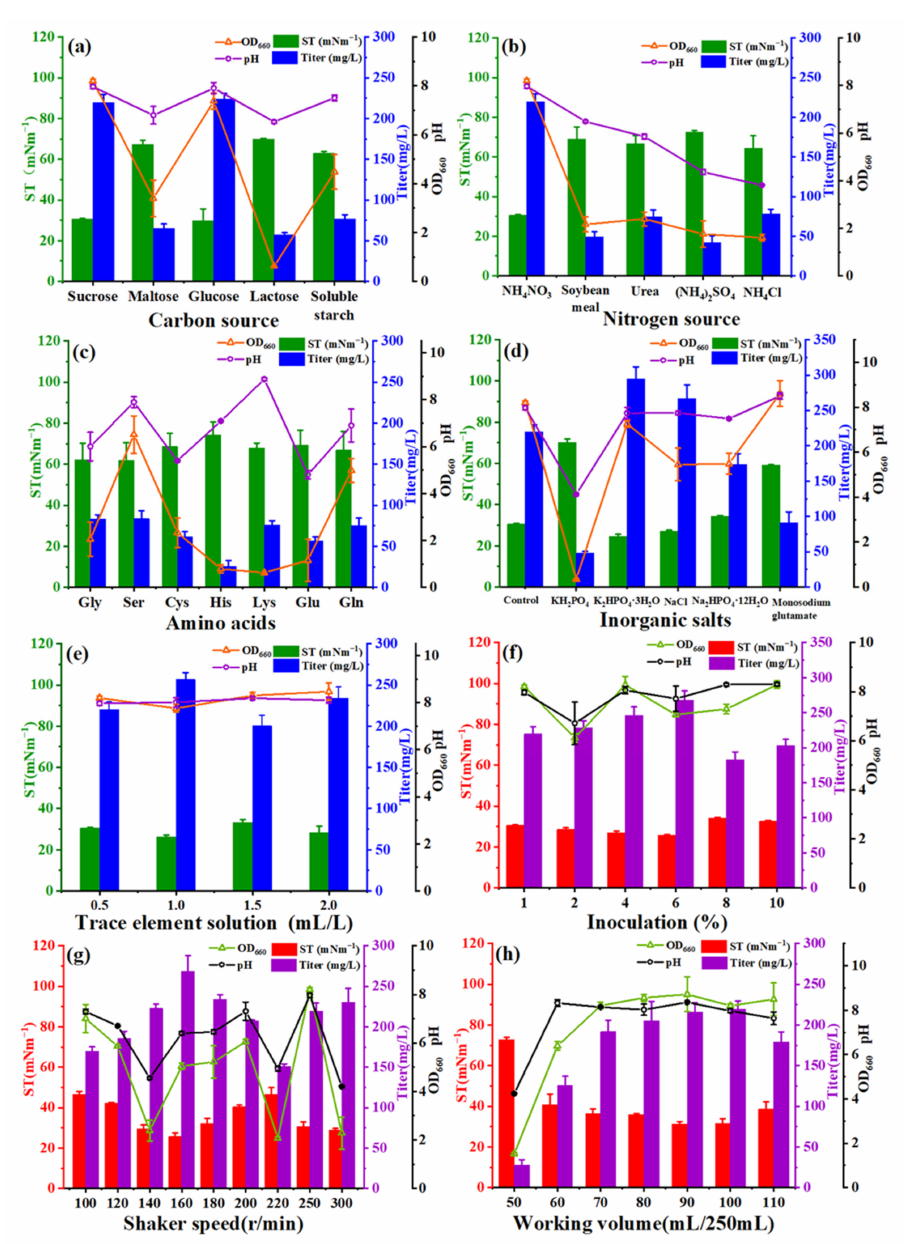
Figure 1. ( a ) Effect of diverse carbon sources on a lichenysin titer. ( b ) Influence of various nitrogen sources on lichenysin titer. ( c ) Impact of distinct amino acids on a lichenysin titer. ( d ) Effect of inorganic salts on lichenysin concentration. Variation of lichenysin concentration with addition of trace element solution ( e ), inoculum volume ( f ), shaker speed ( g ), and working volume ( h